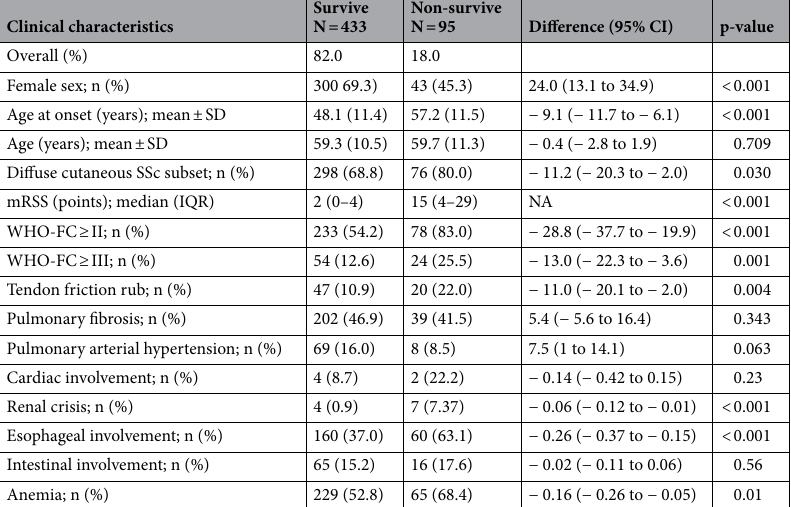
Table 2. Clinical characteristics of survived and non-survivors. SD standard deviation, SSc systemic sclerosis, mRSS modified Rodnan skin score, IQR interquartile range, WHO-FC World Health Organization functional